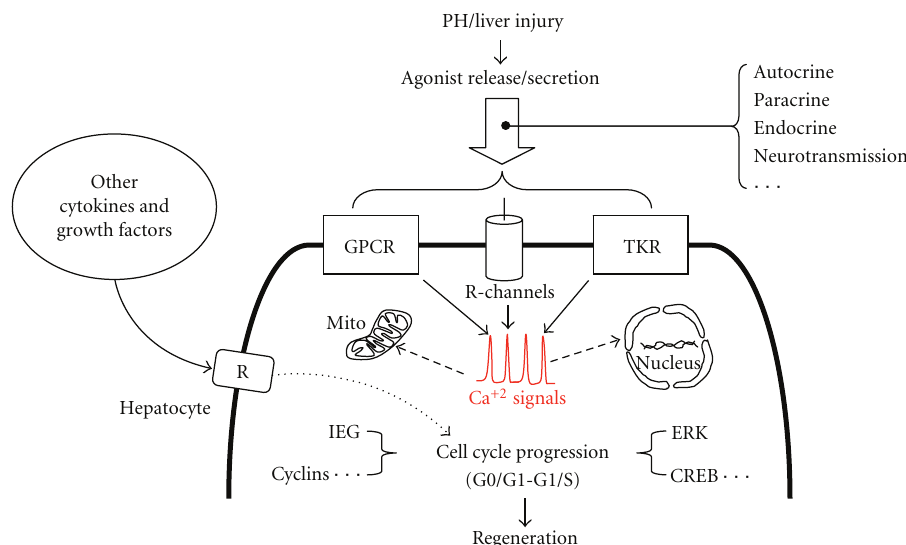
Figure 1: A simplified view of the impact of hepatocyte calcium signals during liver regeneration. After PH or toxic liver injury, a number of calcium mobilizing agonists are released inside or outside the liver, interacting with hepatocytes through autocrine, paracrine, and endocrine pathways. Diverse membrane receptors, either G protein coupled receptors (GPCR), tyrosine kinase receptors (TKR), or receptor channels (e.g., ionotropic purinergic receptors), can be involved in the generation of cytosolic calcium signals. These calcium movements in the cytosol can be transferred to other crucial compartments like the mitochondrion (Mito) or the nucleus, in which they could regulate respectively apoptosis and gene transcription. Previous studies have shown that cytosolic calcium signals regulate cell cycle progression from G0 to G1 and from G1 to S phases in hepatocytes after PH, at least in part through an impact on immediate early genes transcription, cyclin expression, and ERK and CREB